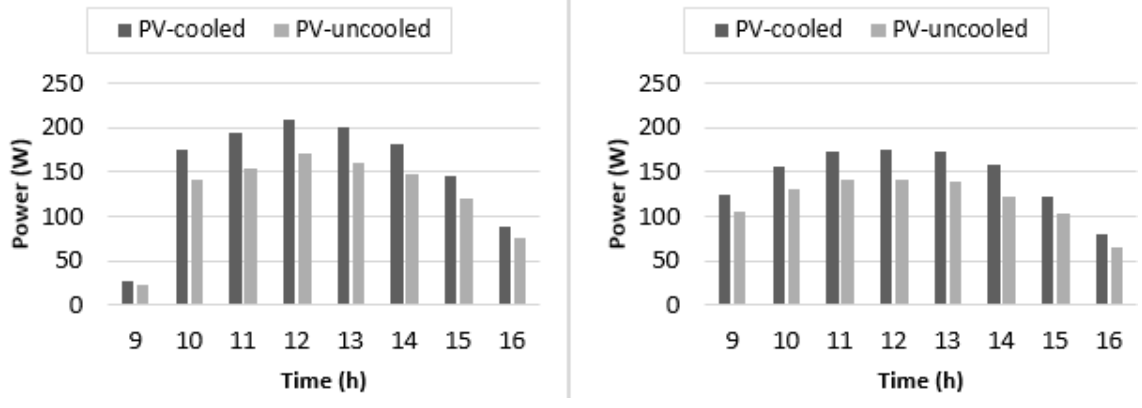
Figure 15. Comparison of power output for flat PV system with and without cooling.